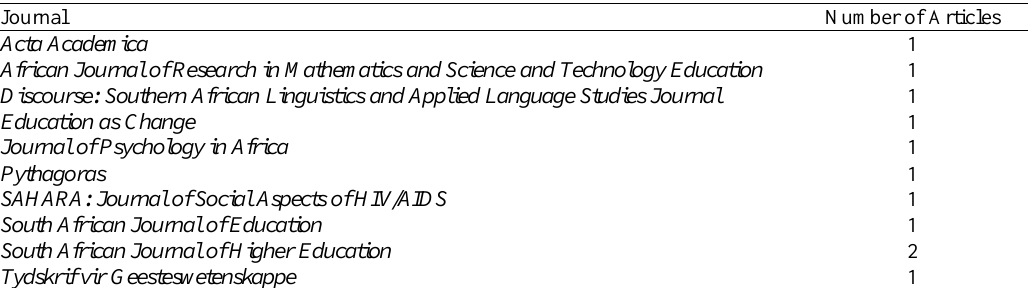
Table 3 South African journals in which articles were published derived from doctoral research completed in fields of education in South Africa in 2008